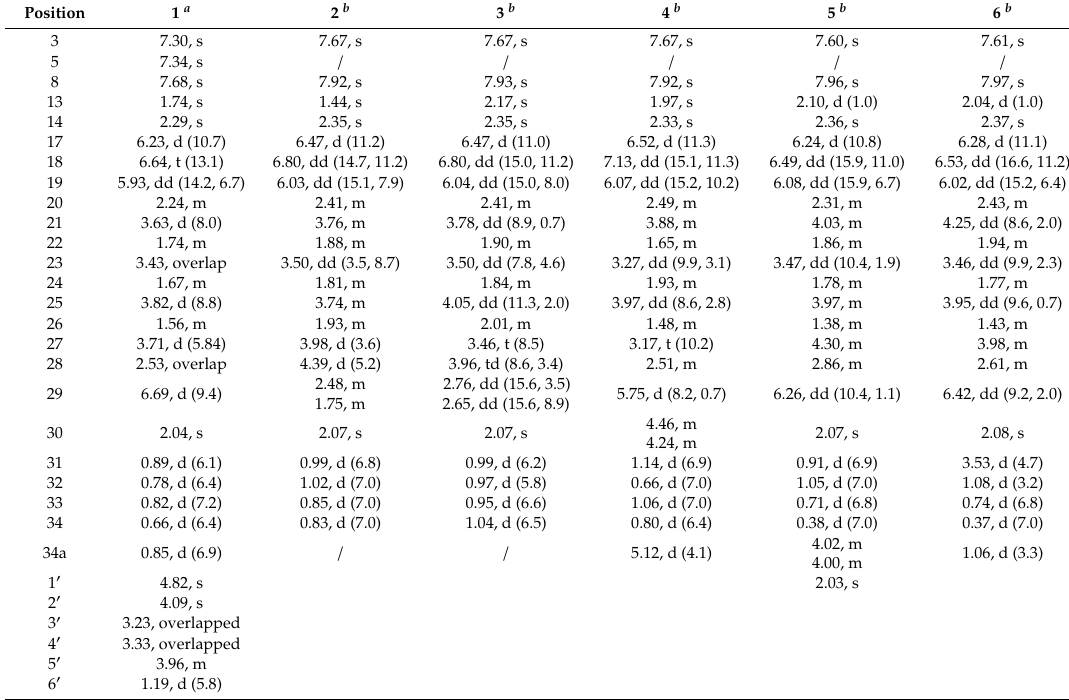
+ 654.2870), and 676.2737 [M + Na] (calculated for C 35 H 43 NO 11 Na Table 1. 1 H NMR Spectroscopic Data of Compounds 1 – 6 ( δ H , J in Hz)